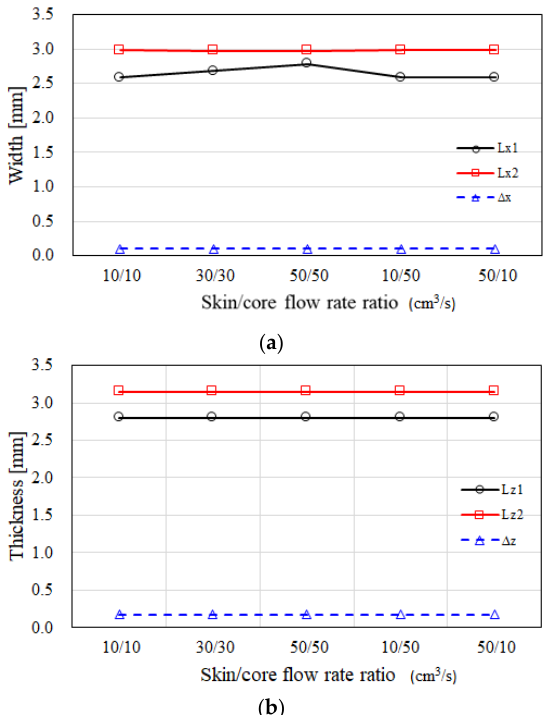
Figure 9. The dimension variation of the CSC structure under the influence of the different skin to core flow rate ratios.